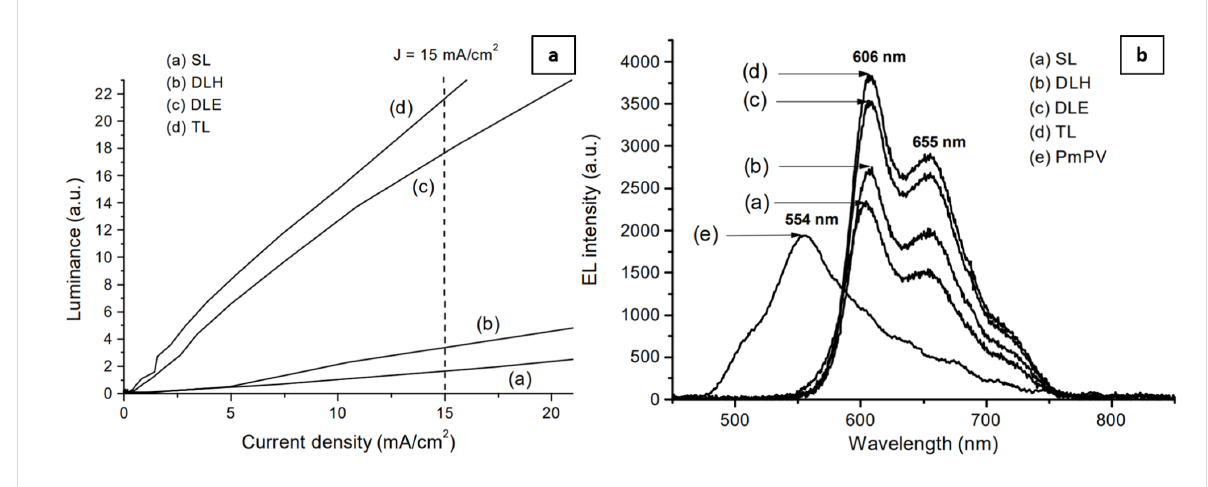
Figure 7: (a) Luminance as a function of current density and (b) EL spectrum for a MWNT concentration of 8 wt % for all the devices. Figure 7a and Figure 7b were adapted from [19], with the permission of AIP Publishing. This content is not subject to CC BY 4.0.